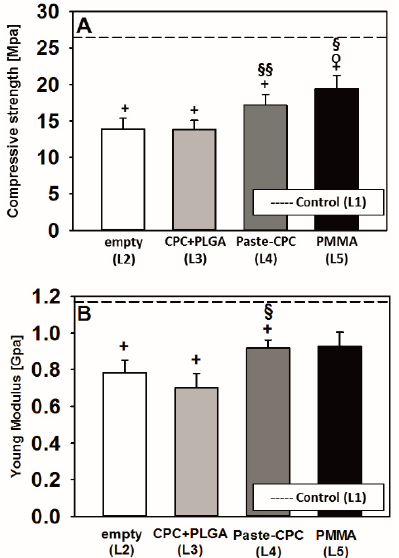
Figure 5. Compressive strength ( A ) and Young’s modulus ( B ) of vertebral spongiosa cylinders fol- lowing application of CPC + PLGA (L3), Paste-CPC (L4), or PMMA (L5); + p ≤ 0.05 versus untouched control (L1); O p ≤ 0.05 versus empty defect (L2); § p ≤ 0.05, §§ p ≤ 0.01 versus CPC + PLGA (L3); mean values of untouched control vertebrae are indicated by dashed lines. CPC, calcium phosphate cement; PLGA, poly(L-lactide-co-glycolide); PMMA,